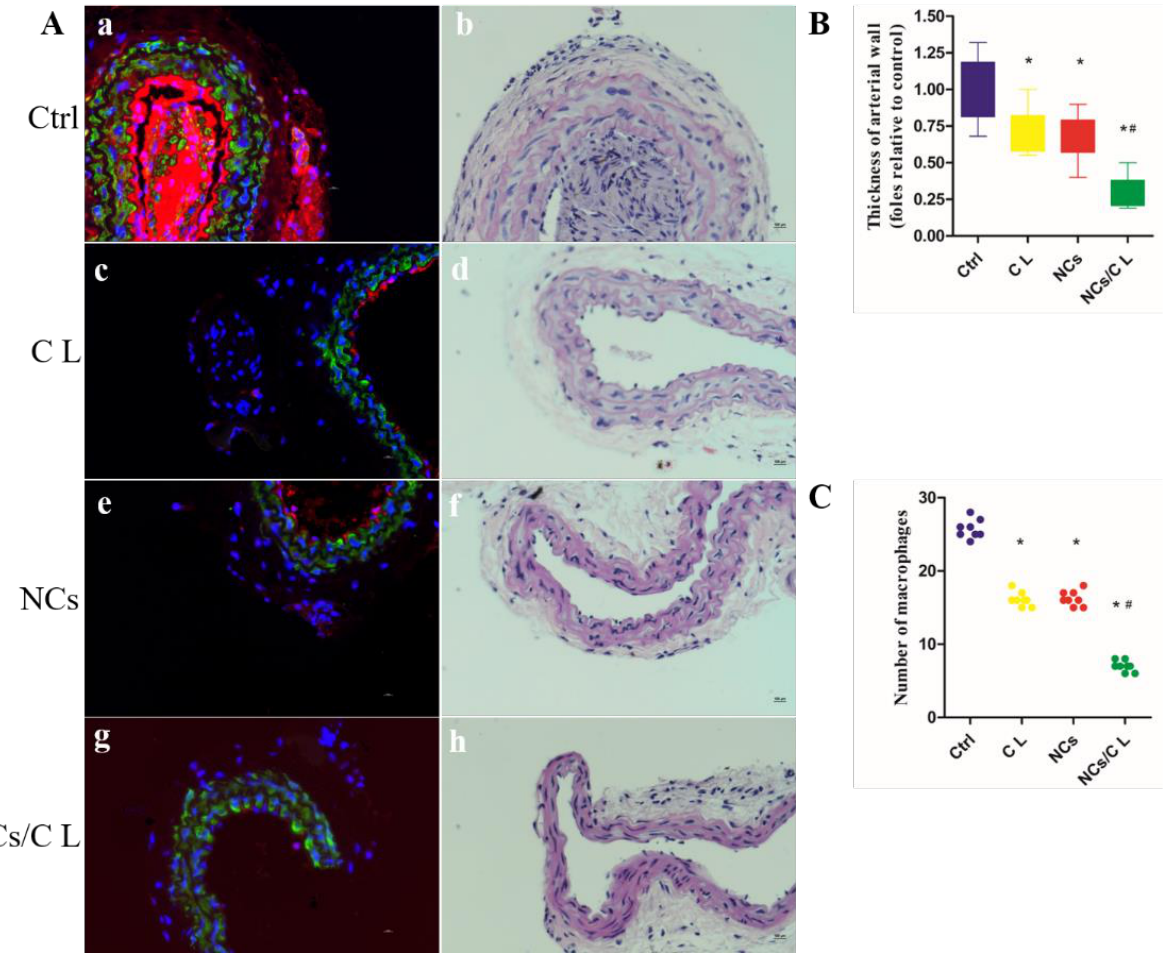
Figure 5. Histological analysis of carotid atherosclerosis in mice. ( A ) Confocal images of CD68 (red) and SMA (green) co-staining of carotid artery treated with PBS (control, ( a )), CL ( c ), CuCo 2 S 4 NCs ( e ), and CuCo 2 S 4 NCs/CL ( g ), followed by NIR laser irradiation, respectively. ( b , d , f , h ) are the representative HE images treated with PBS (control), CL, CuCo 2 S 4 NCs, and CuCo 2 S 4 NCs/CL, followed by NIR laser irradiation, respectively. Scale bar = 100 µ m. ( B ) Quantification of thickness of arterial wall. ( C ) Quantification of number of macrophages. *: p < 0.05 vs. control, # : p < 0.05 vs. CL.